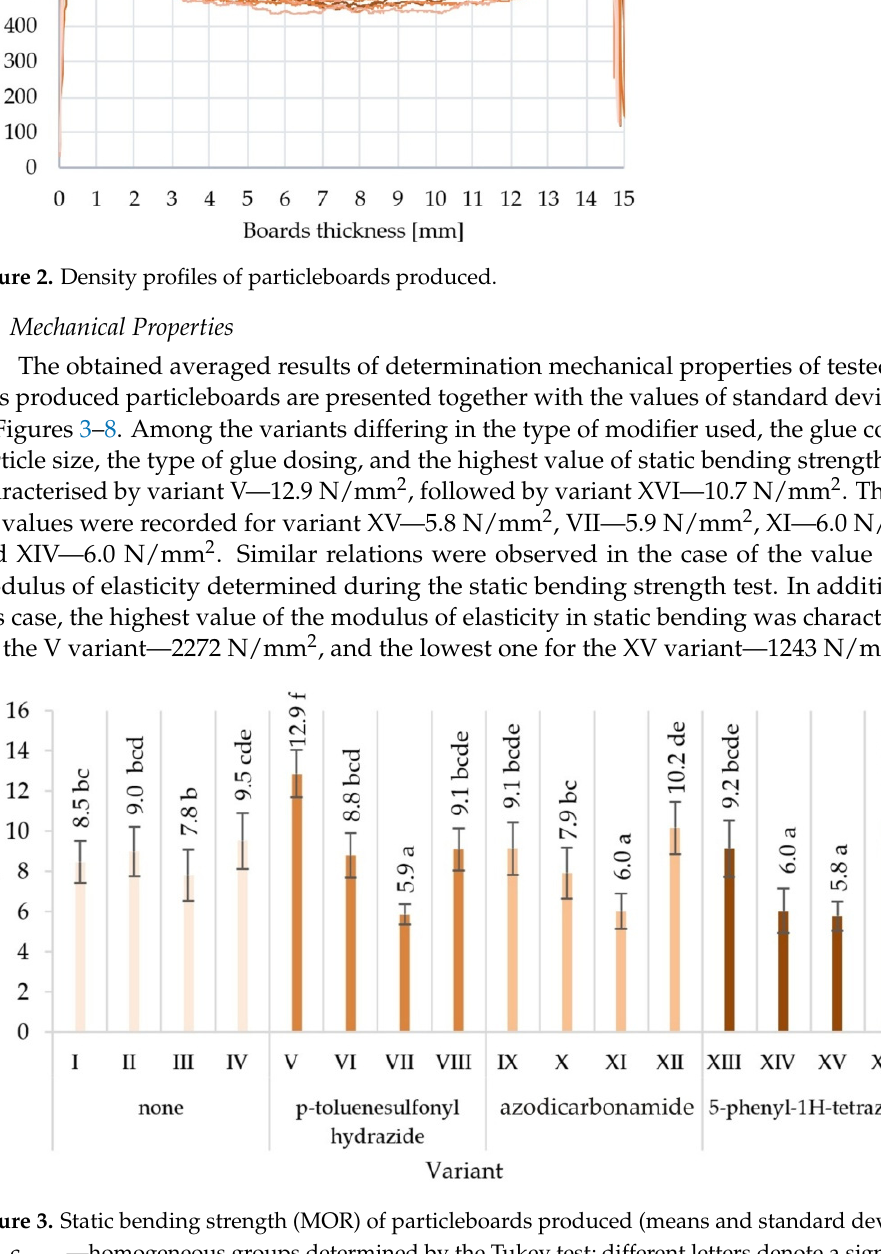
Figure 4. Modulus of elasticity (MOE) of particleboards produced (means and standard deviation, a, b, c, …—homogeneous groups determined by the Tukey test; different letters denote a signifi- cant difference; means followed by the same letter do not statistically differ from each other).